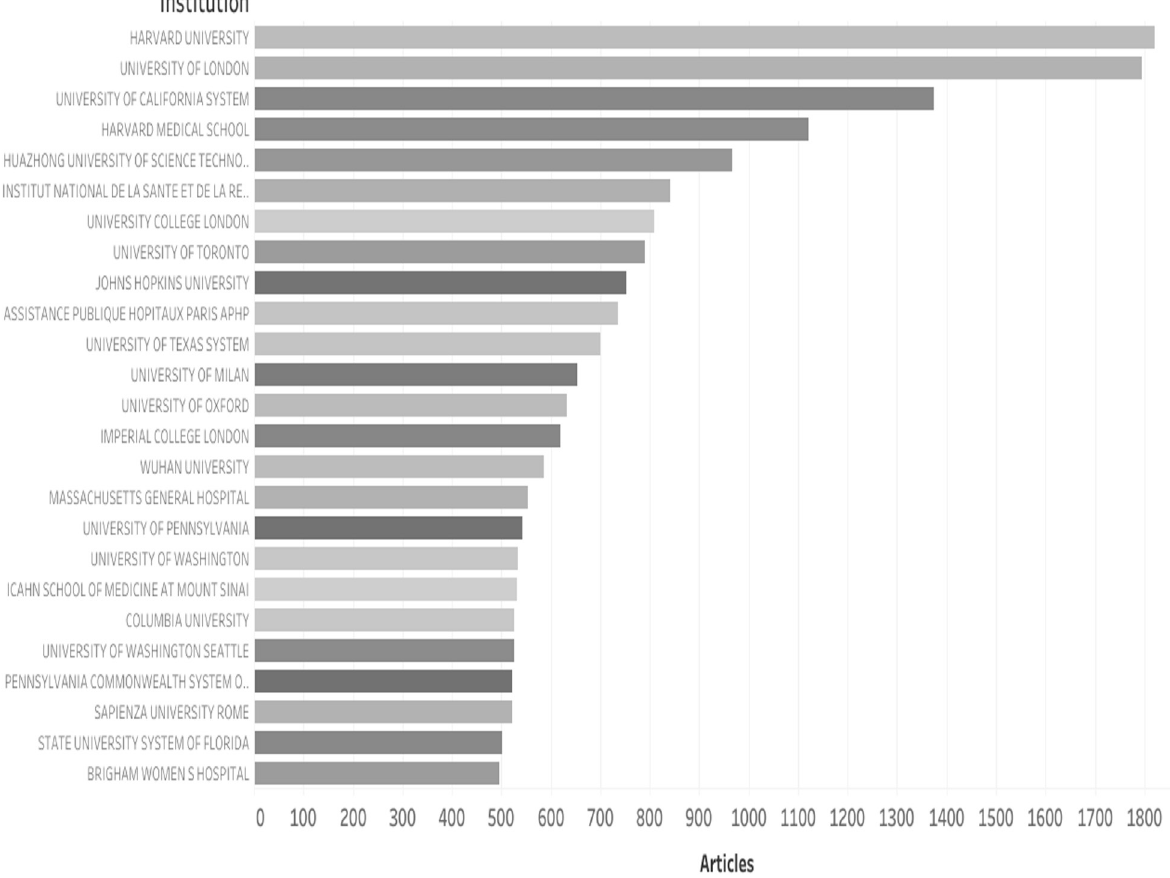
Figure 3. Output of scientific articles related to COVID-19 by the most productive research